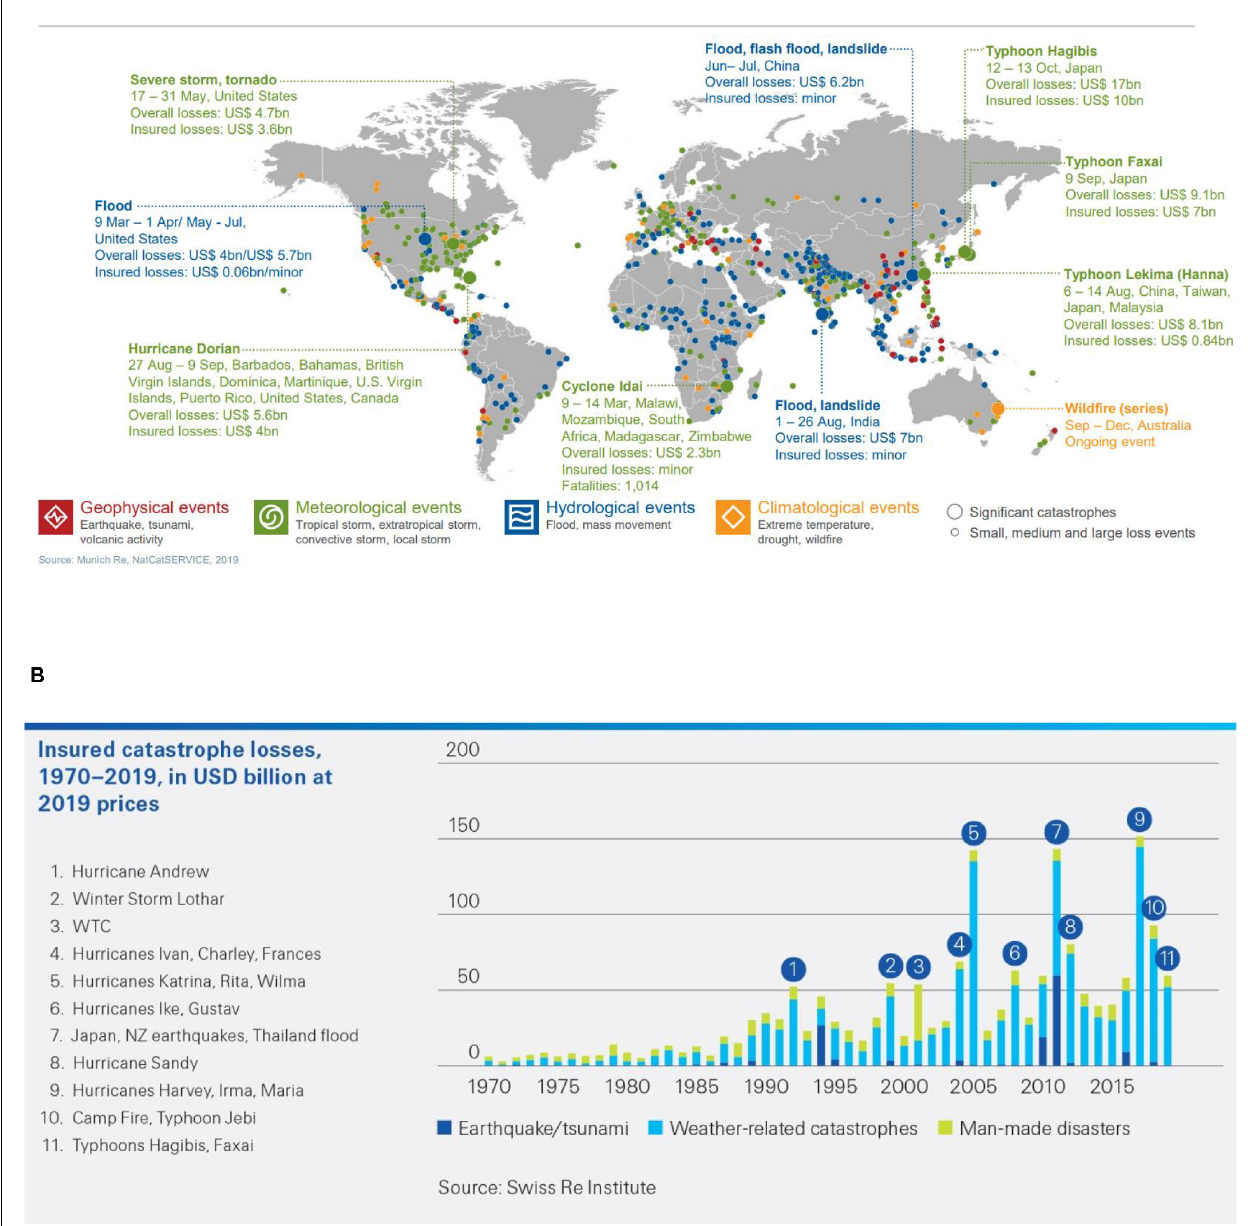
exhibited high levels of respiratory irritation were 150:1 in the morning and 100:1 in the afternoon (Hoagland et